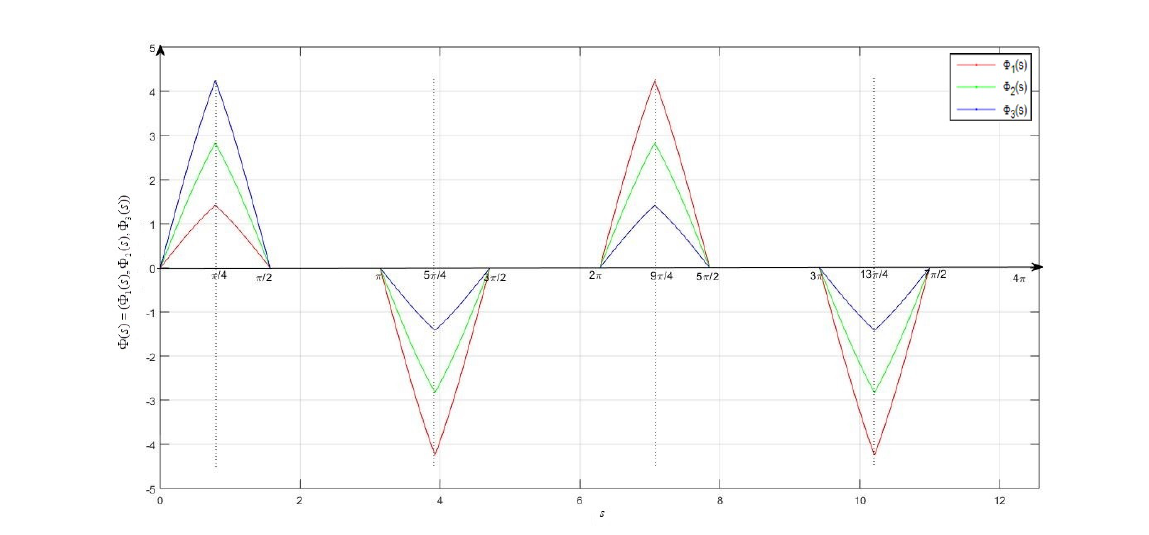
Figure 1. Graphical Representation of Φ ( s ) in Example